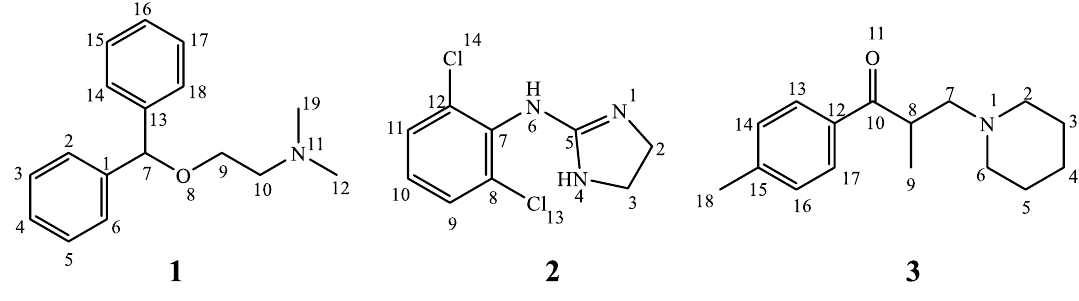
Fig. 1 Structures of (1) diphenhydramine, (2) clonidine and (3) tolperisone. Drawn in